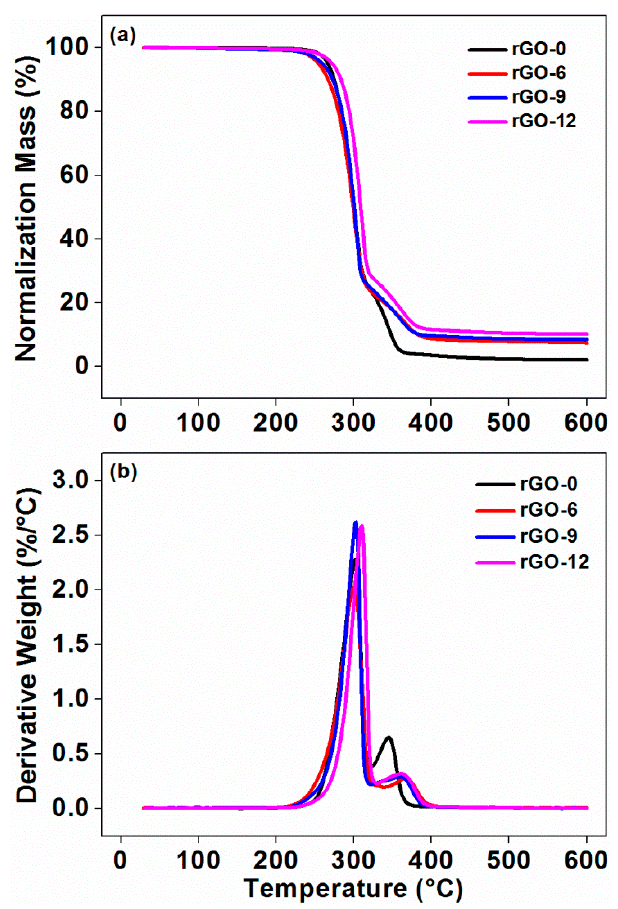
Figure 7. Thermogravimetry (TG) ( a ) and differential TG (DTG) ( b ) curves of the composites with different rGO contents.